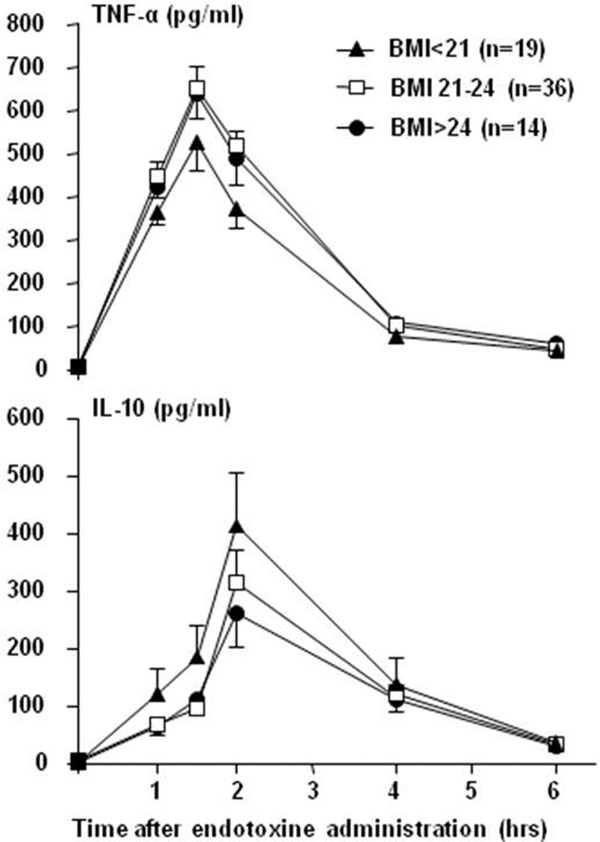
Effects of 2 ng/kg Escherichia coli endotoxin (LPS) (administered at 0 hours) in subjects with BMI <21 and BMI >24 kg/m2 on the production of TNFα and IL-10. Data expressed as mean ± SEM.